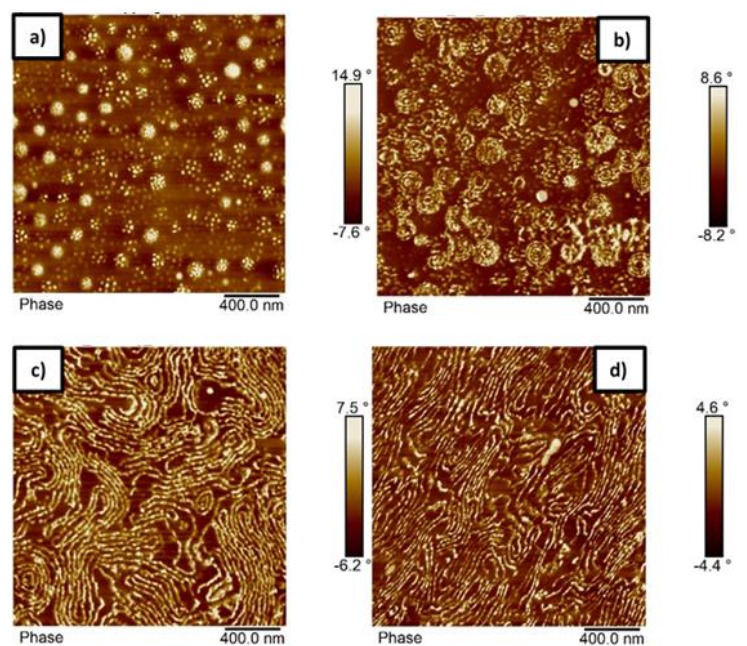
Figure 7. AFM phase images of the sample p(St15-2EHA70-St15) ( a ) top surface of the film dried at room temperature ( b ) cross-section of the film dried at room temperature, ( c ) cross-section of the film dried at 100 °C and ( d ) cross-section of a film cast from THF-solution.